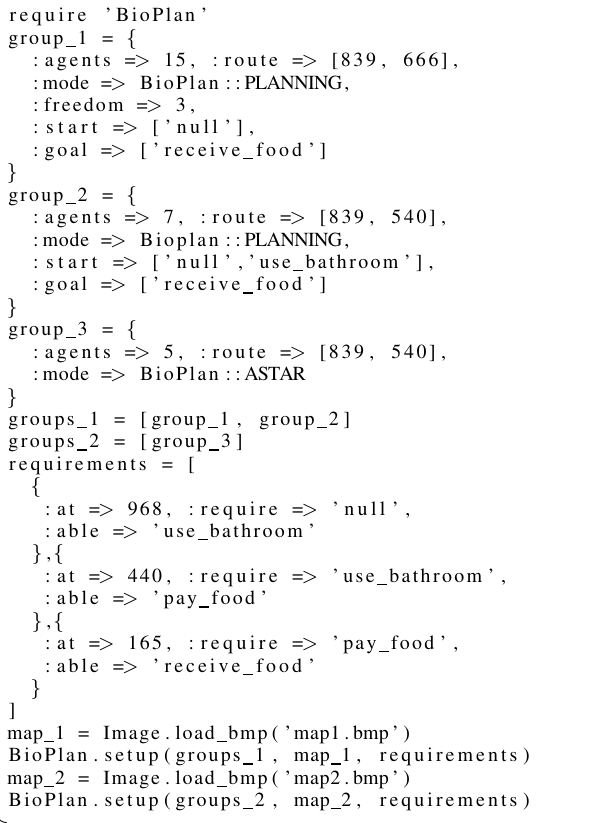
Fig. 10. With the map loaded we generate the required paths for each group and save to files to be used as input in the simulator.